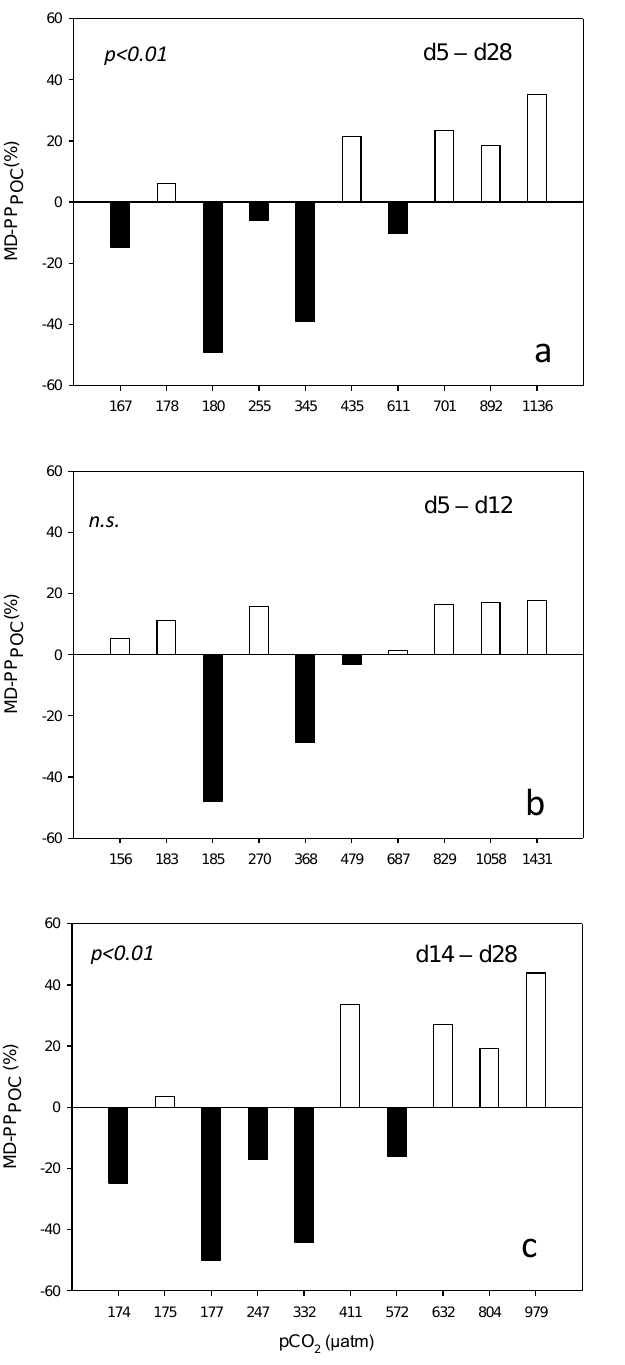
Fig. 8. Mean deviations of PP POC (MD-PP POC , %) for the nine mesocosms and for the fjord (left bar) calculated for (a) the total period of observation (day 5–day 28; n = 12), (b) the period be- fore nutrient addition (day 5–day 12; n = 4), and (c) the period after nutrient addition (day 14–day 28; n = 8). Significance of relation between MD-PP POC and average p CO 2 at the time of observation was calculated by linear regression.